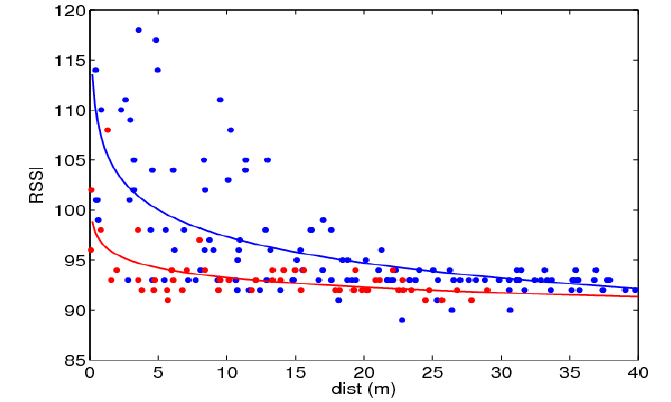
Figure 8. Statistical distribution of signal strength readings versus distance, for tags in front (blue) and behind (red) the traffic signal; and best fits produced with a path-loss model for signal